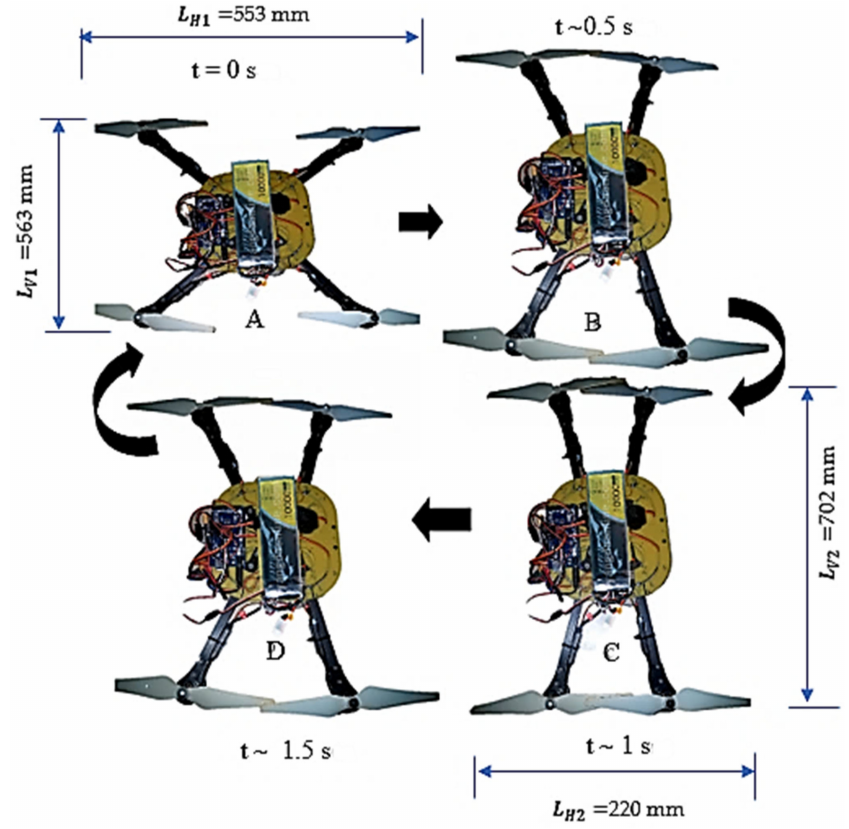
Figure 8. Unfolded and folded configuration of